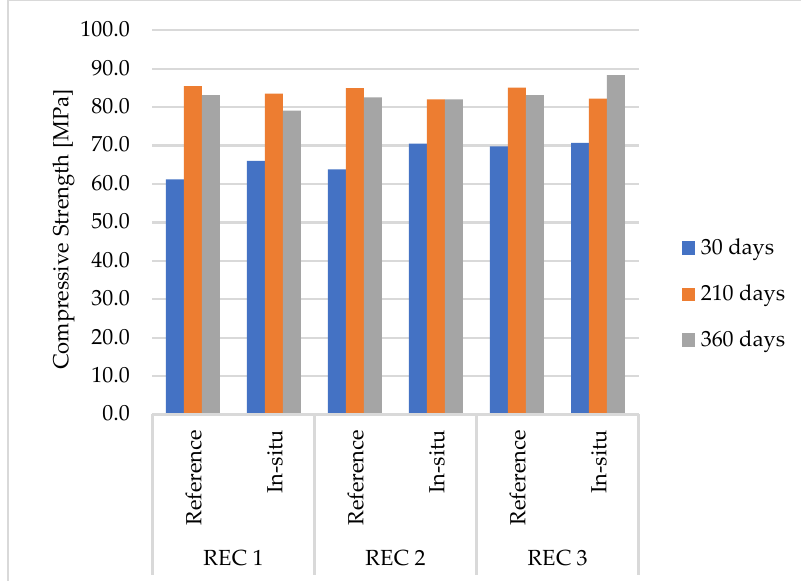
Figure 5. Compressive strength of mixtures.